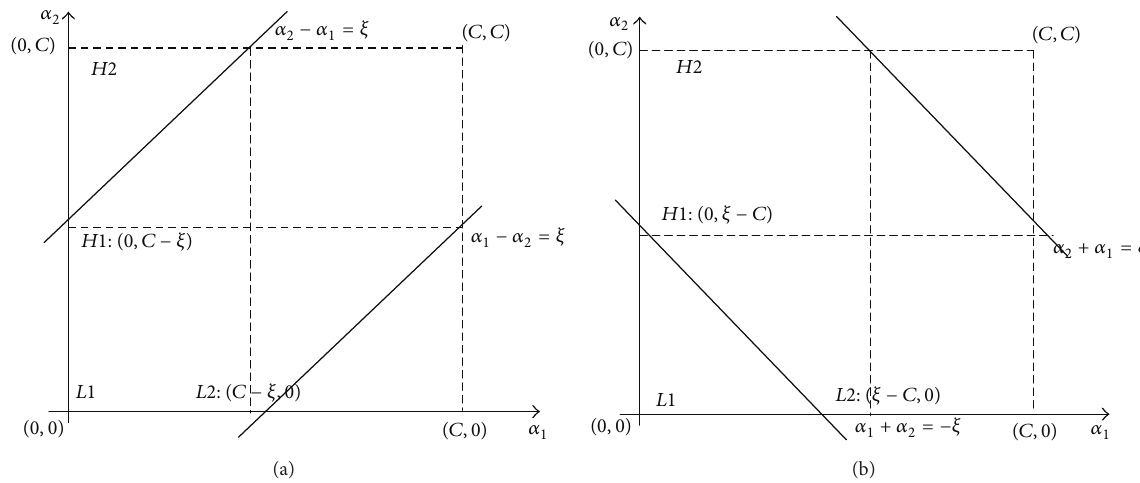
Figure 1: Parameter training process of SMO. (a) Adjustment of the parameter when Y1Y2 = 1. (b) Adjustment of the parameter when Y1Y2 = −